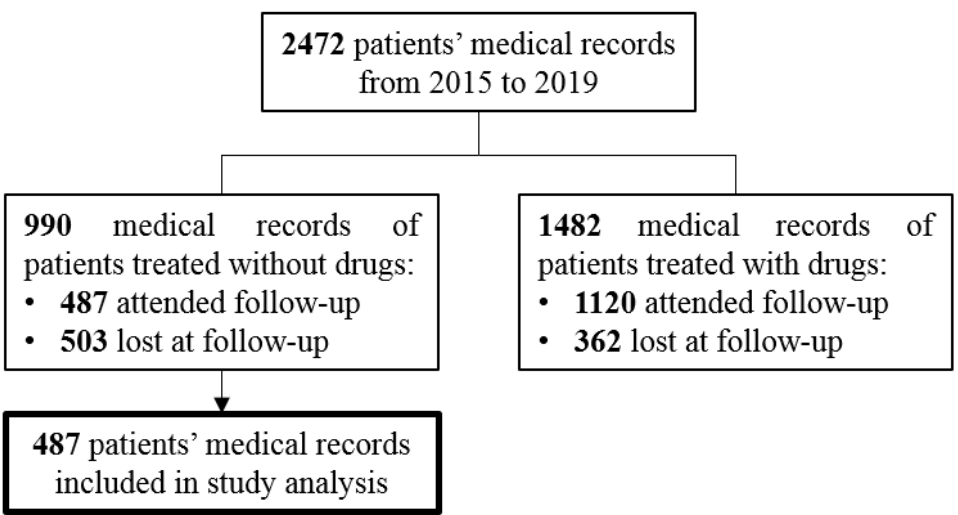
Figure 1. Flow chart of study design and allocation criteria and grouping for patients’ former analysis.